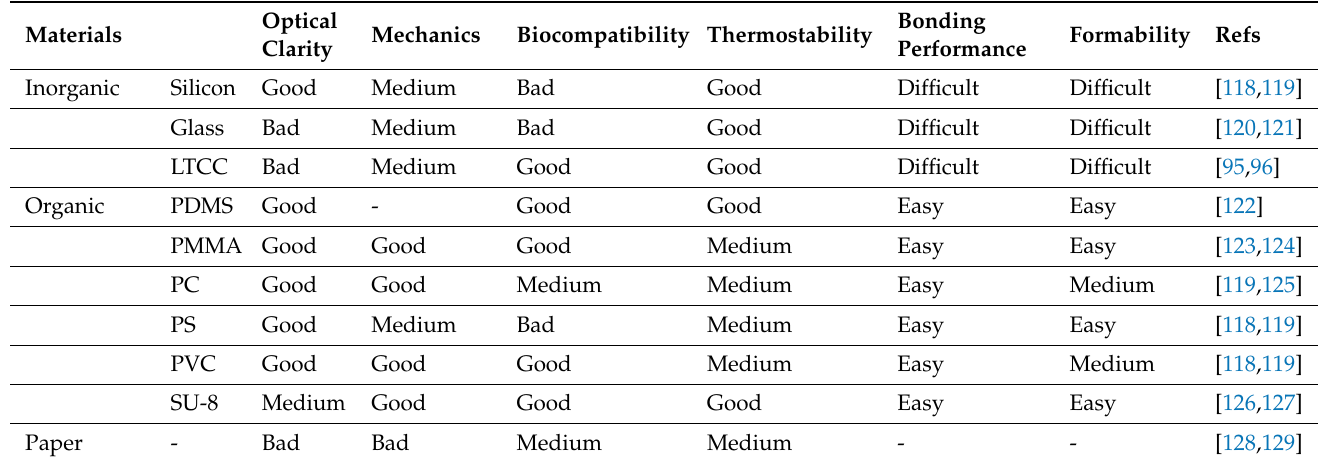
Table 2. Summary of the common materials for microfluidic